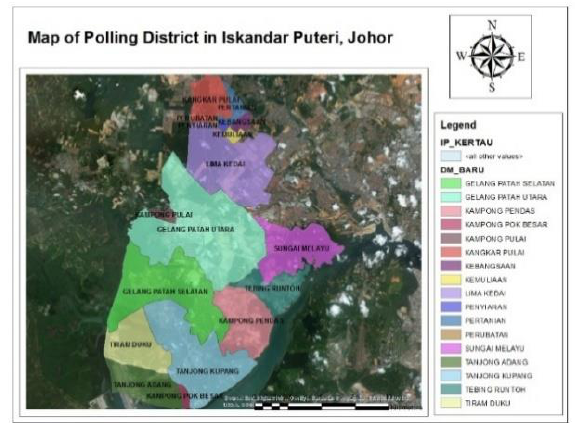
Figure 4. Polling district boundary in Nusajaya